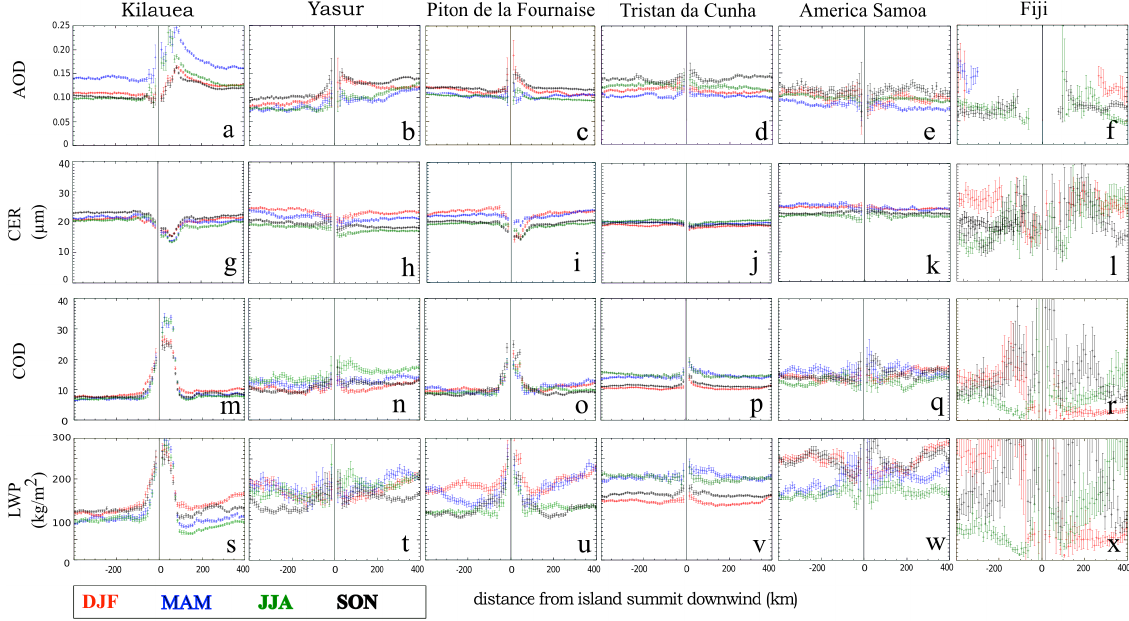
Figure 3. Profiles of average aerosol and cloud properties upwind and downwind of the degassing volcano: K¯ılauea, Hawai’i; Yasur, Vanuatu and Piton de la Fournaise, Réunion and at “control” islands: Tristan da Cunha, South Atlantic; American Samoa, West Pacific and Fiji, West Pacific. Profile values are the average of arcs of π at equal distance upwind and downwind from the volcano vent for MODIS Aqua data from 2 between 2002 and 2013. Separate profiles for different time of year are shown in different colours: December–February in red, March–May in blue, June–August in green and September–November in black. Error bars show one standard error for this average and are generally larger for low sample sizes. Positive values on the x -axis are downwind, negative are upwind. The maximum diameter of the islands is indicated on the parameter plots as black dashed lines.